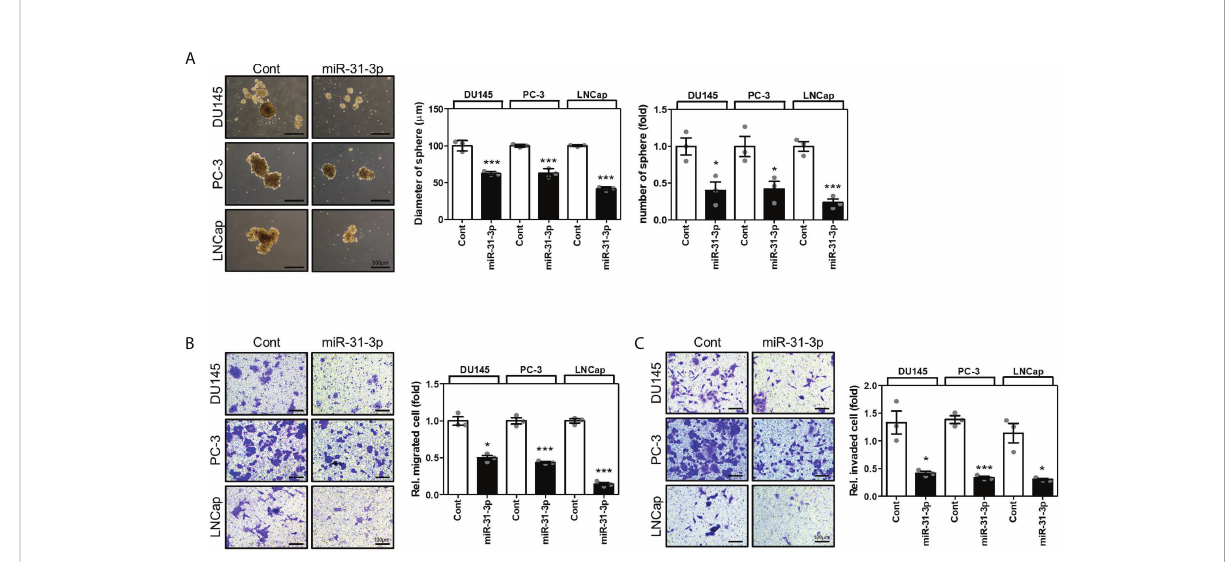
FIGURE 2 miR-31-3p represses sphere formation, migration, and invasion in prostate cancer (PC) cells. (A) miR-31-3p suppresses sphere formation by DU145, PC-3, and LNCap cells. Representative microscopy images are shown. An unpaired two-tailed Student ’ s t -test was used to calculate P values. Error bars represent mean ± standard error of the mean (SEM). *P value < 0.05 and ***P value < 0.001 vs. Cont (n = 3). (B) miR-31-3p inhibits DU145, PC-3, and LNCap cell migration. An unpaired two-tailed Student ’ s t -test was used to calculate P values. Error bars represent mean ± SEM. *P value < 0.05 and ***P value < 0.001 vs. Cont (n = 3). (C) miR-31-3p inhibits DU145, PC-3, and LNCap cell invasion. An unpaired two-tailed Student ’ s t -test was used to calculate P values. Error bars represent mean ± SEM. *P value < 0.05 and ***P value < 0.001 vs. Cont (n =